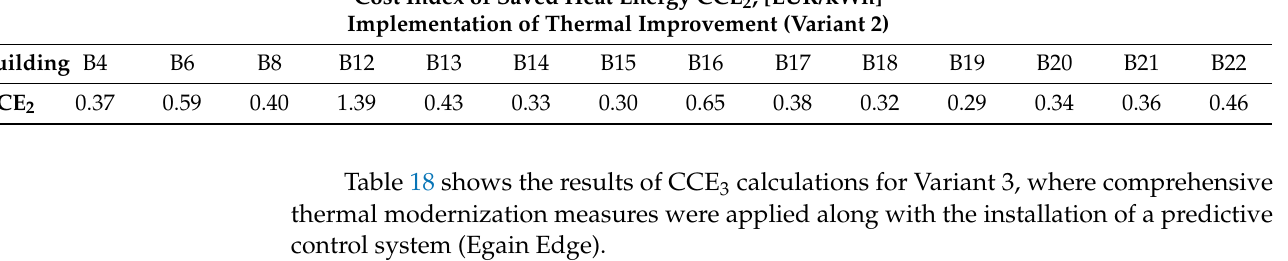
Table 18. Value of cost index of saved energy for heating after thermal improvement with installation of Egain Edge predictive control system CCE 3 ,